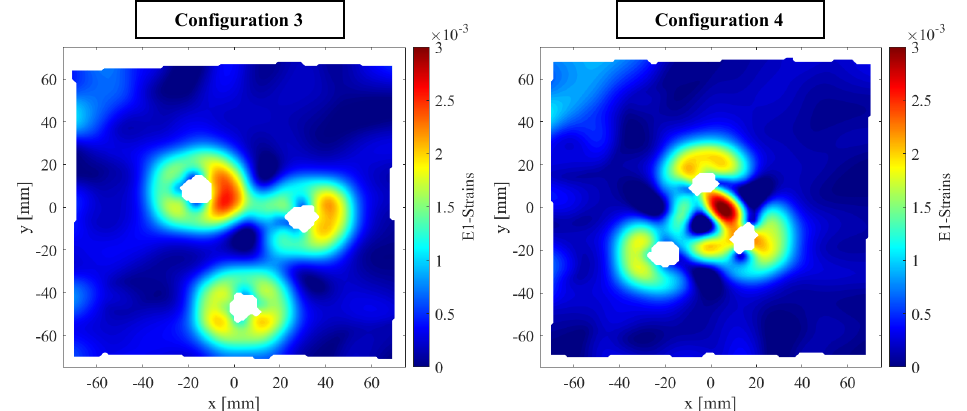
Figure 13. Comparison between the major principal strain fields of configurations 3 and